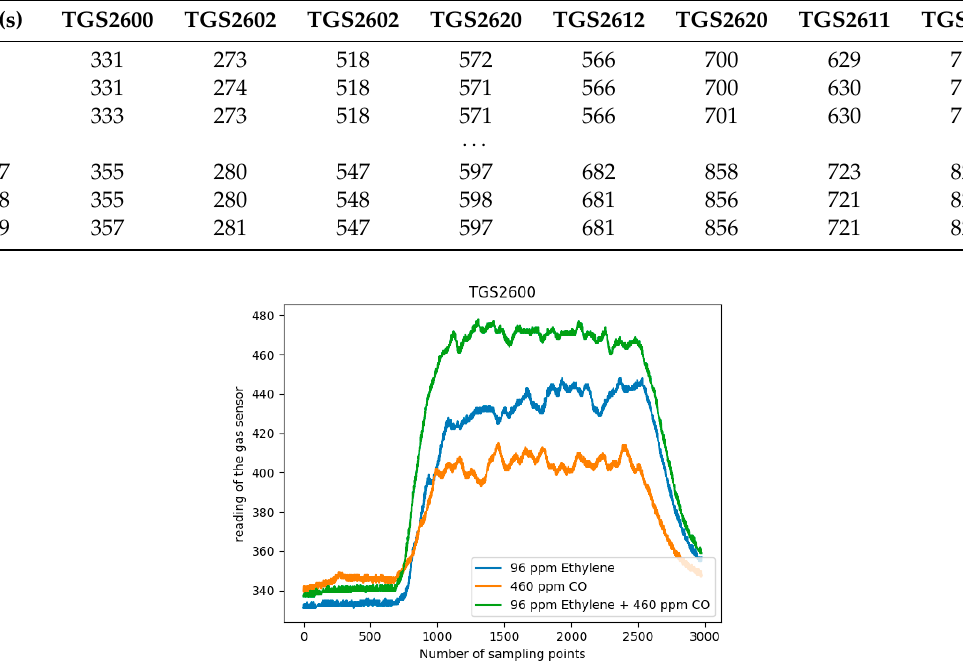
Table 3. A sample of the original data.